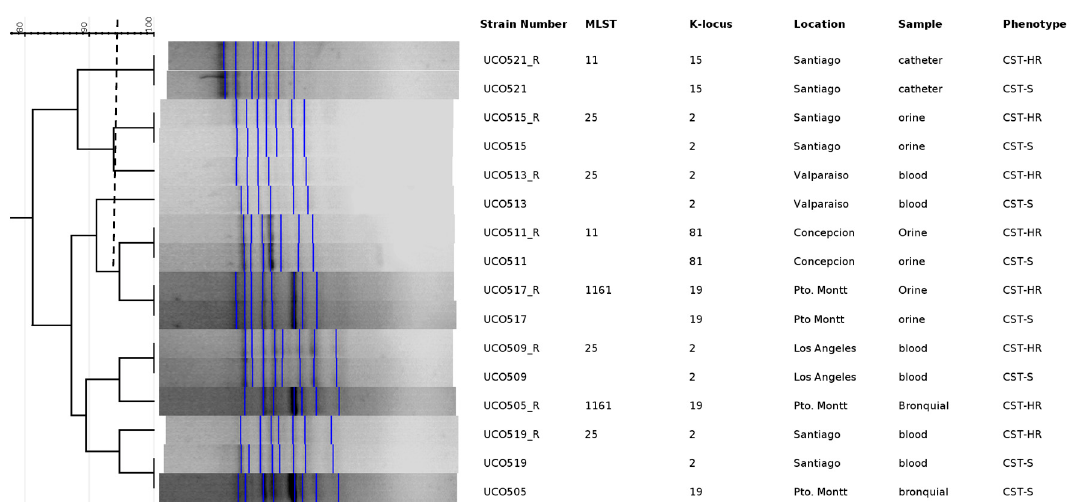
Figure A1. Dendrogram for ERIC-PCR between susceptible and heteroresistant sub-populations. CST-S: colistin susceptible; CST-HR: colistin heteroresistant. A Dice’s index of >90% similarity was considered indistinguishable (dotted line).